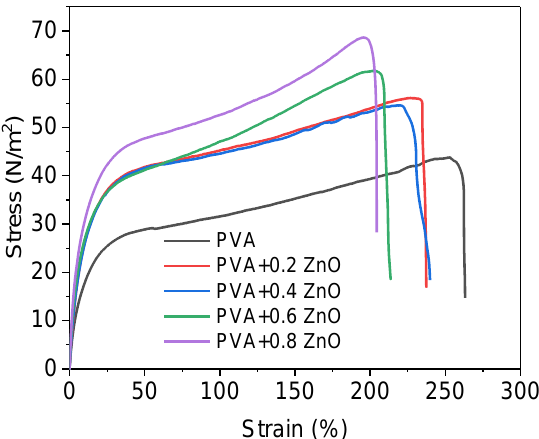
Figure 10. Stress versus strain graph of ZnO weight concentration with 0.2 weight percent ZnO shown by the red line, 0.4 weight percent by the blue line, 0.6 weight percent by the green line, and 0.8 weight percent by the purple line. A simple PVA film is represented by the black line.